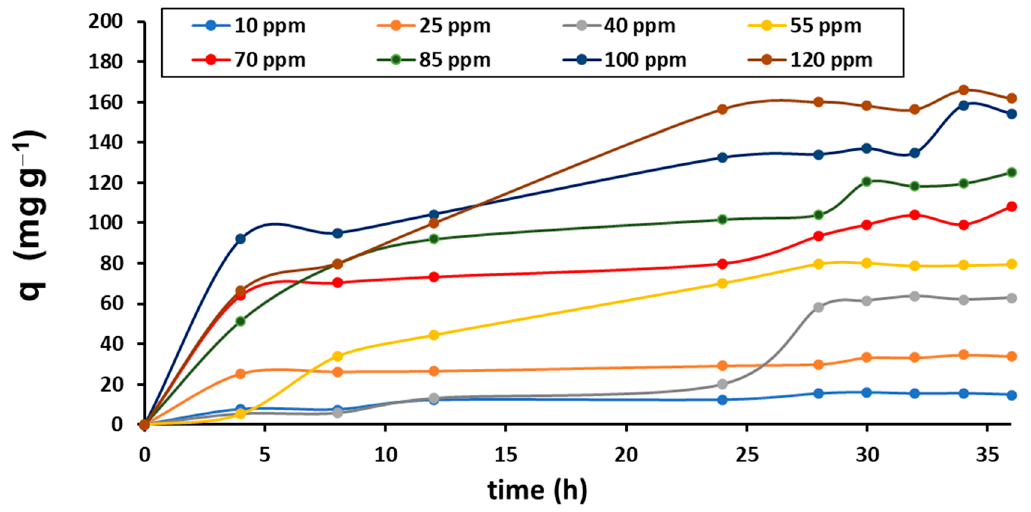
Figure 6. Cr(VI) adsorption kinetics.